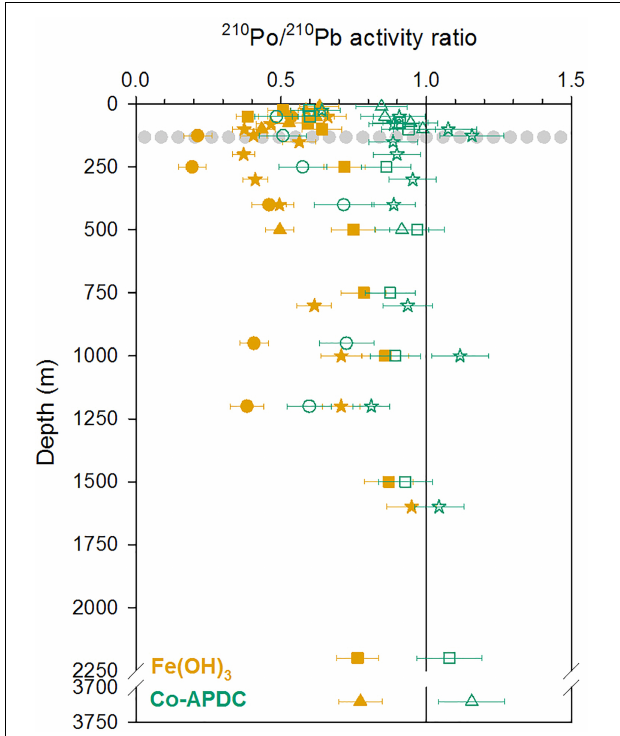
FIGURE 4 | 210 Po/ 210 Pb activity ratio determined by using the Fe(OH) 3 (yellow, closed symbols) and Co-APDC (green, open symbols) methods. Symbols denote different study areas: IONIAN (triangles), CBN (squares), CBS (circles), and SOTS (stars). The vertical solid line indicates 210 Po/ 210 Pb activity ratio = 1.0, and the horizontal dotted line is the average depth of the primary production zone in the study